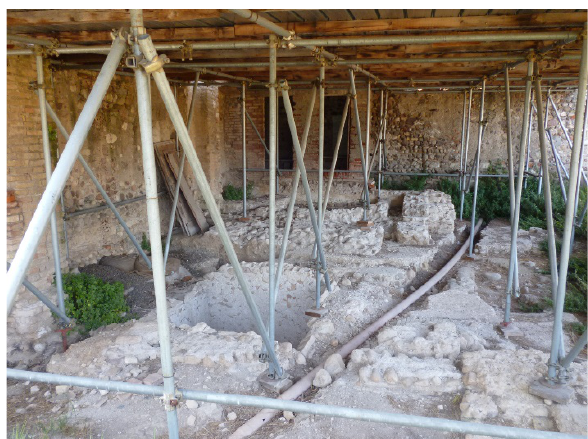
Figure 2: view of the archaeological area. The temporary roof cover lies directly on the archaeological structures, only protected by some protective